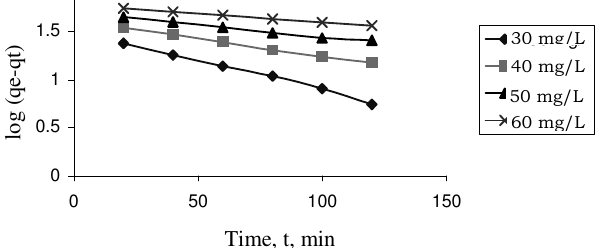
Figure 8 . First order plot – initial Grey BL concentration variation.